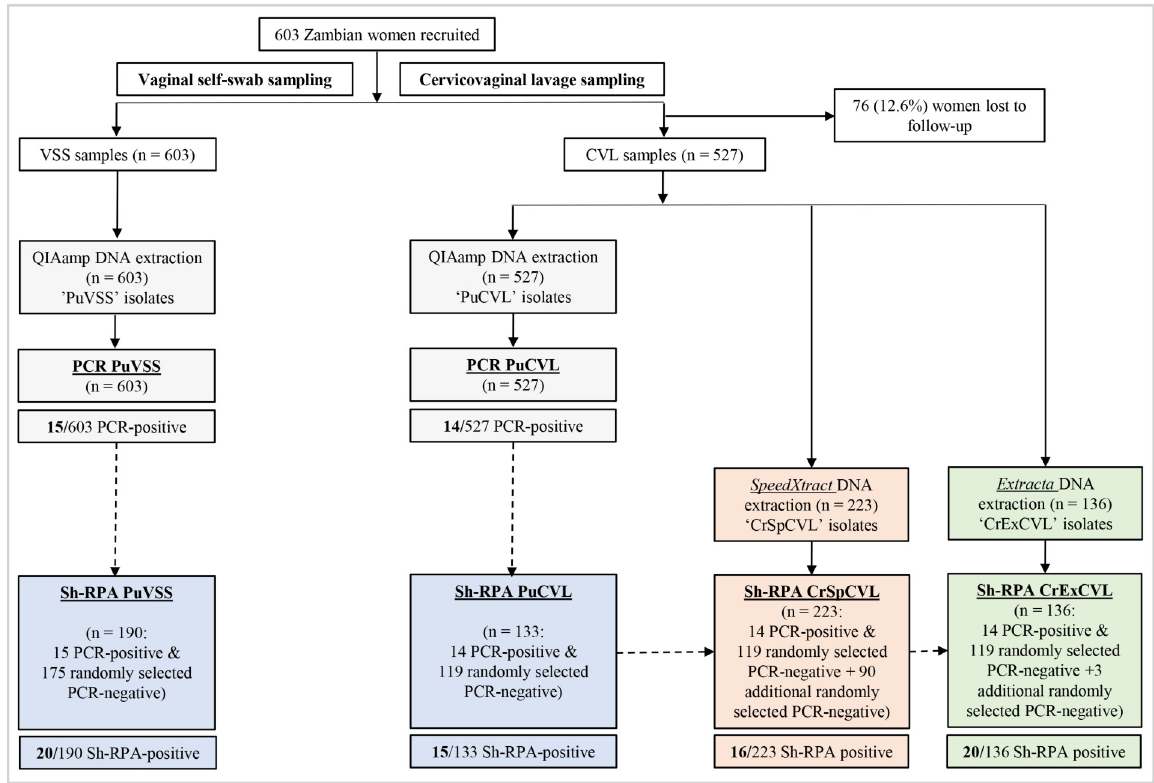
Fig 2. Flow schematic outlining participant recruitment, clinical samples provided by patients, DNA isolation methods used and molecular diagnostic assessment (real-time PCR and Sh-RPA). DNA isolation and real-time PCR carried out by Sturt et al ., [40] is coloured grey. DNA isolation and Sh-RPA carried out here is coloured according to DNA extraction method used: QIAamp Mini Kit : blue, SpeedXtract : orange, Extracta : green. Dashed arrows are used to illustrate that real-time PCR data obtained during [40] was used to determine which VSS and CVL samples would be selected for Sh-RPA analysis. Sh-RPA performance and sample preparation comparisons are detailed in Table 1.